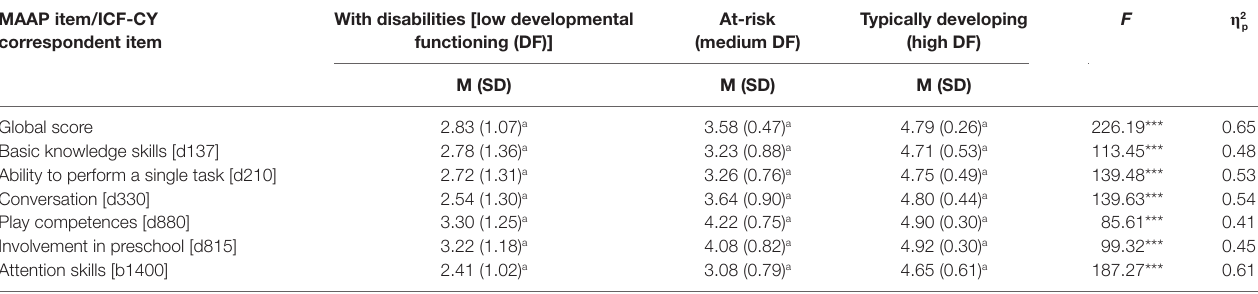
tablE 1 | Mean differences for each of the MAAP-short version measure item/International Classification of Functioning Disability and Health – Children and Youth version (ICF-CY) code, between the three groups of children: with disabilities, at-risk and typically developing. maap item/icF-cy correspondent item